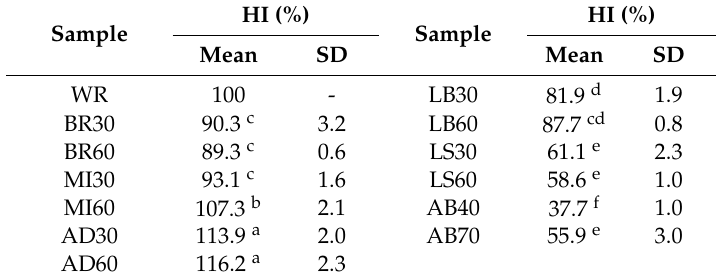
Table 4. The hydrolysis index of test foods (Mean values with their standard deviations (SD), n = 6). HI Sample